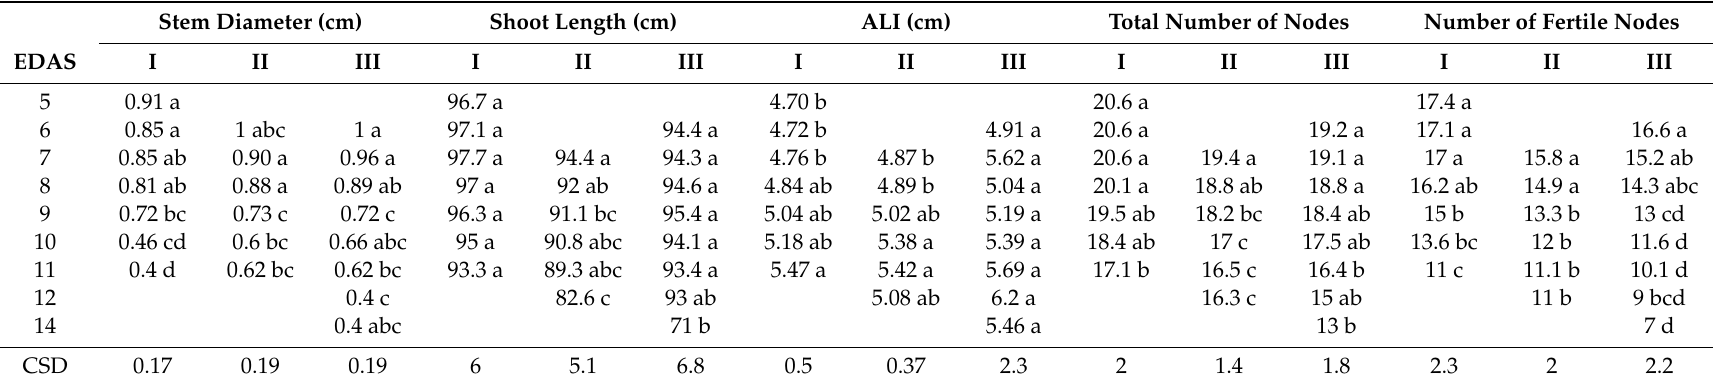
Table 4. Stem diameter, shoot length, average length of internodes (ALI), total numbers of nodes, and number of fertile nodes at stage R 8 in soybean plants from distinct emergence days after sowing (EDAS)* at the three sites (I, II, and III). Stem Diameter